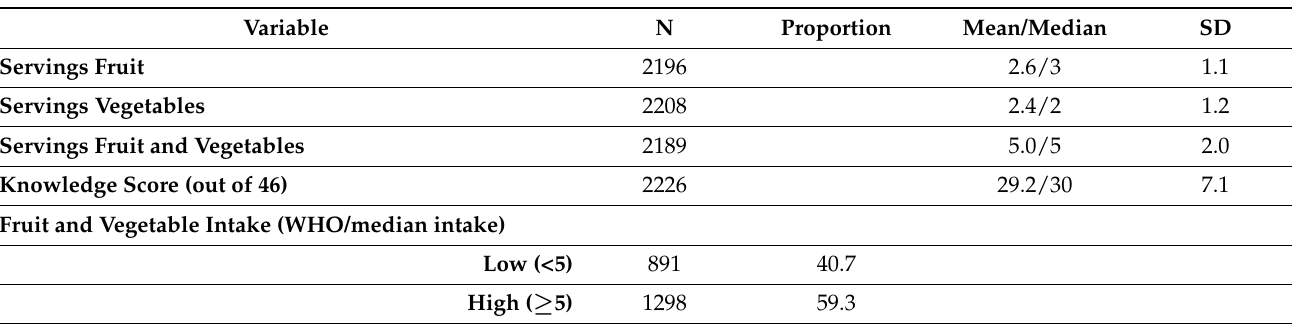
Table 2. Dietary Intake and Food Knowledge Score.